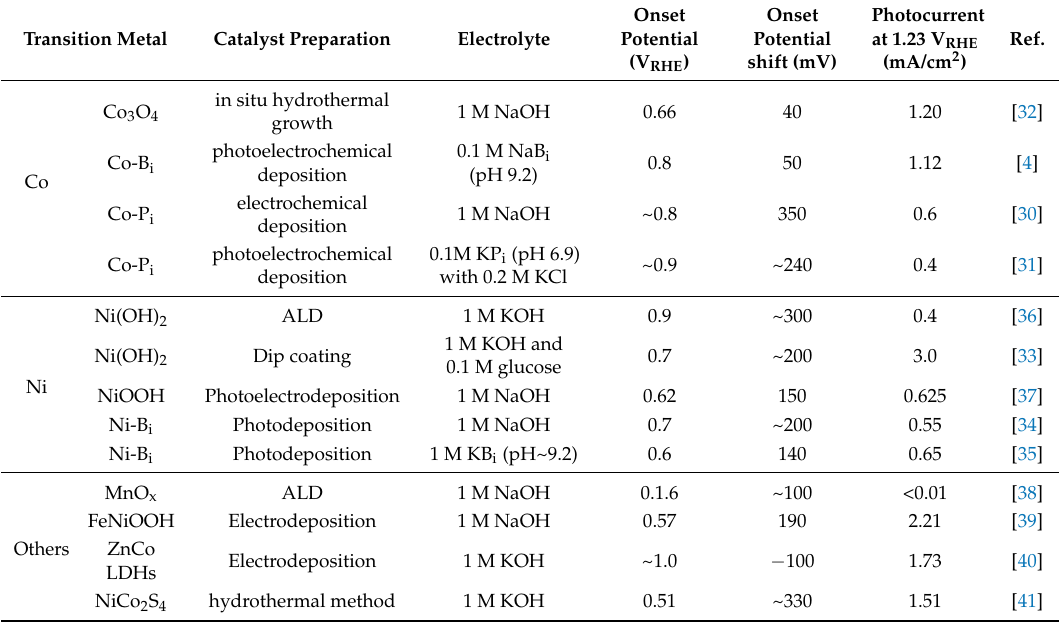
Table 2. List of earth abundant metal based co-catalysts used for surface modification on hematite